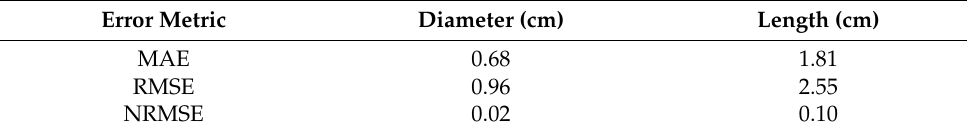
Table 1. Results on errors for the first experiment